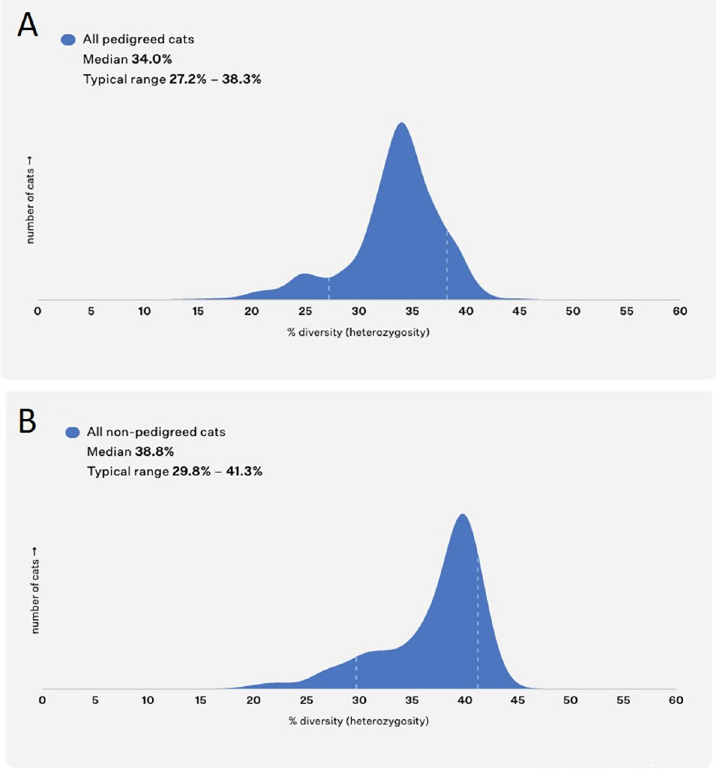
Fig 2. The median genetic diversity in pedigree and non-pedigreed cat populations with typical range (the 10th and 90th percentile).